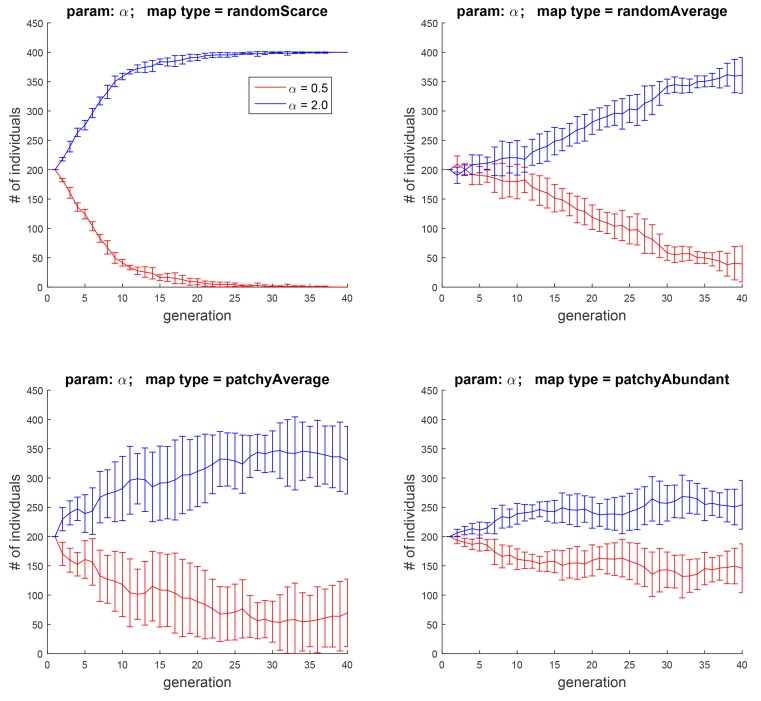
Experiment 2B: the effect of the contribution of food rewards to H, when two subpopulations with α = 0.5 and α = 2.0 pitched against each other.As in Fig 5, the effect is more pronounced when food is food is not abundant.